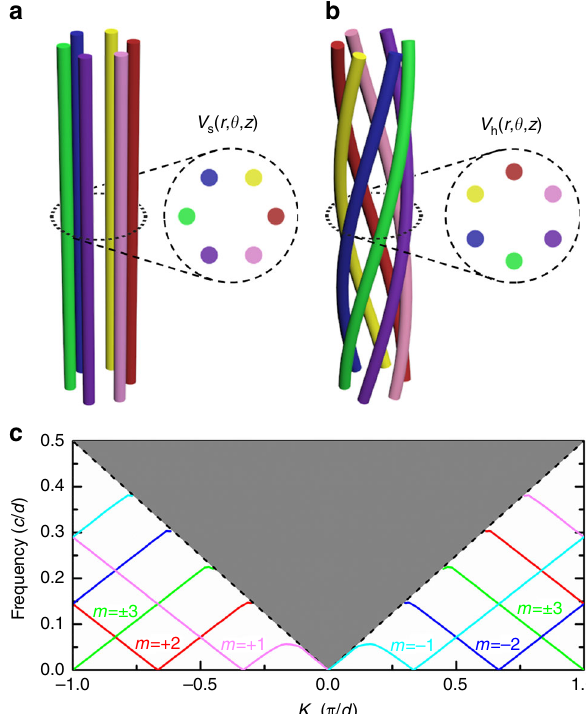
Fig. 2 Canonical momentum generated by twisting. a Schematic of a 1D wire bundle. b Schematic of a helical wire bundle. c Dispersion diagram of the helical bundle shown in b . The gray area denotes the projected light cone. The colored lines highlight the modes propagating along the wires. The different colors indicate modes with different angular momentum m